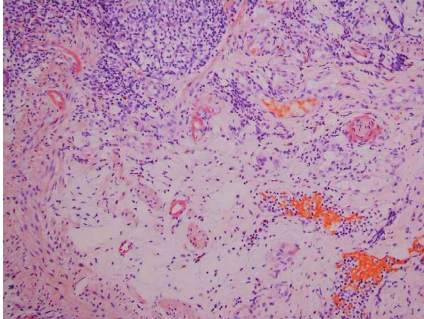
Figure 2: Rectal biopsy with Congo Red stain. Amyloid deposition is seen in the rectal mucosal vessel walls and lamina propria.